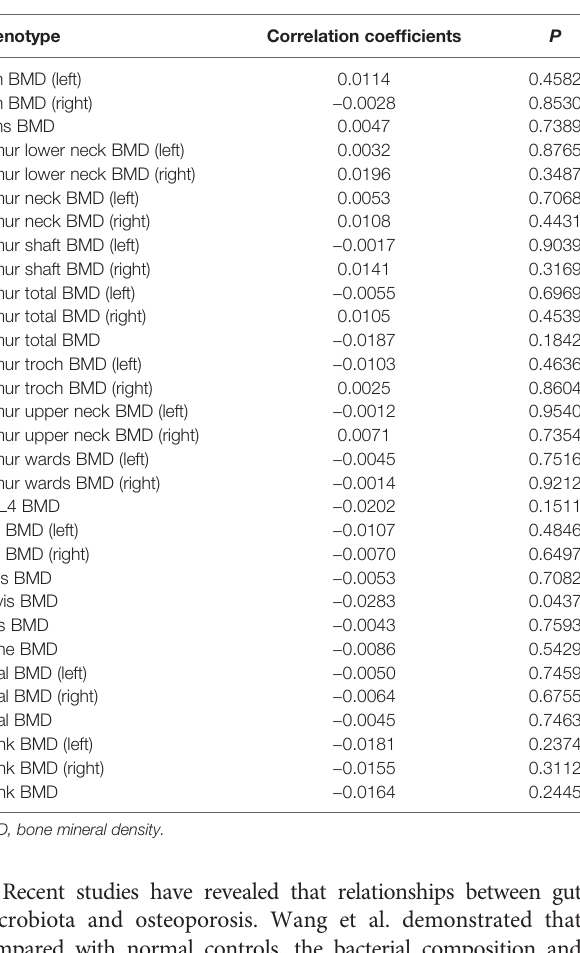
TABLE 2 | List of the correlation between BMD of 31 different sites and gut